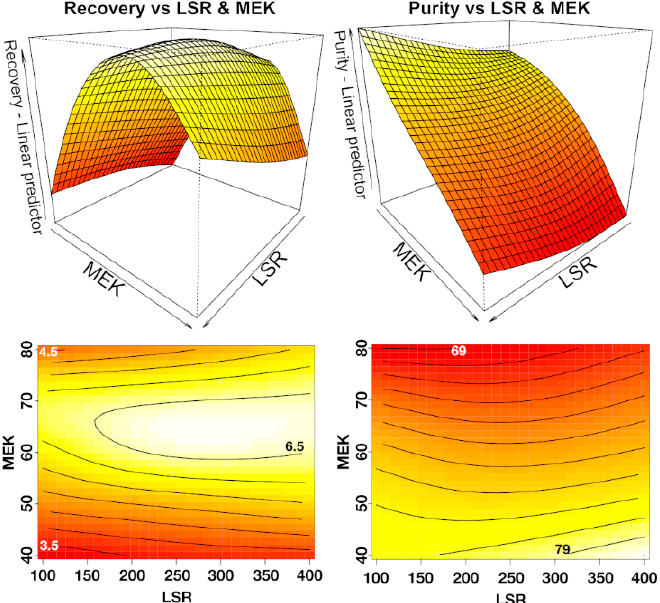
Figure 5. Response surface ( top ) and contour plot ( bottom ) of the recovery ( left , mg/g DW) and purity ( right , %) of JB with the combined effect of LSR and methyl ethyl ketone.